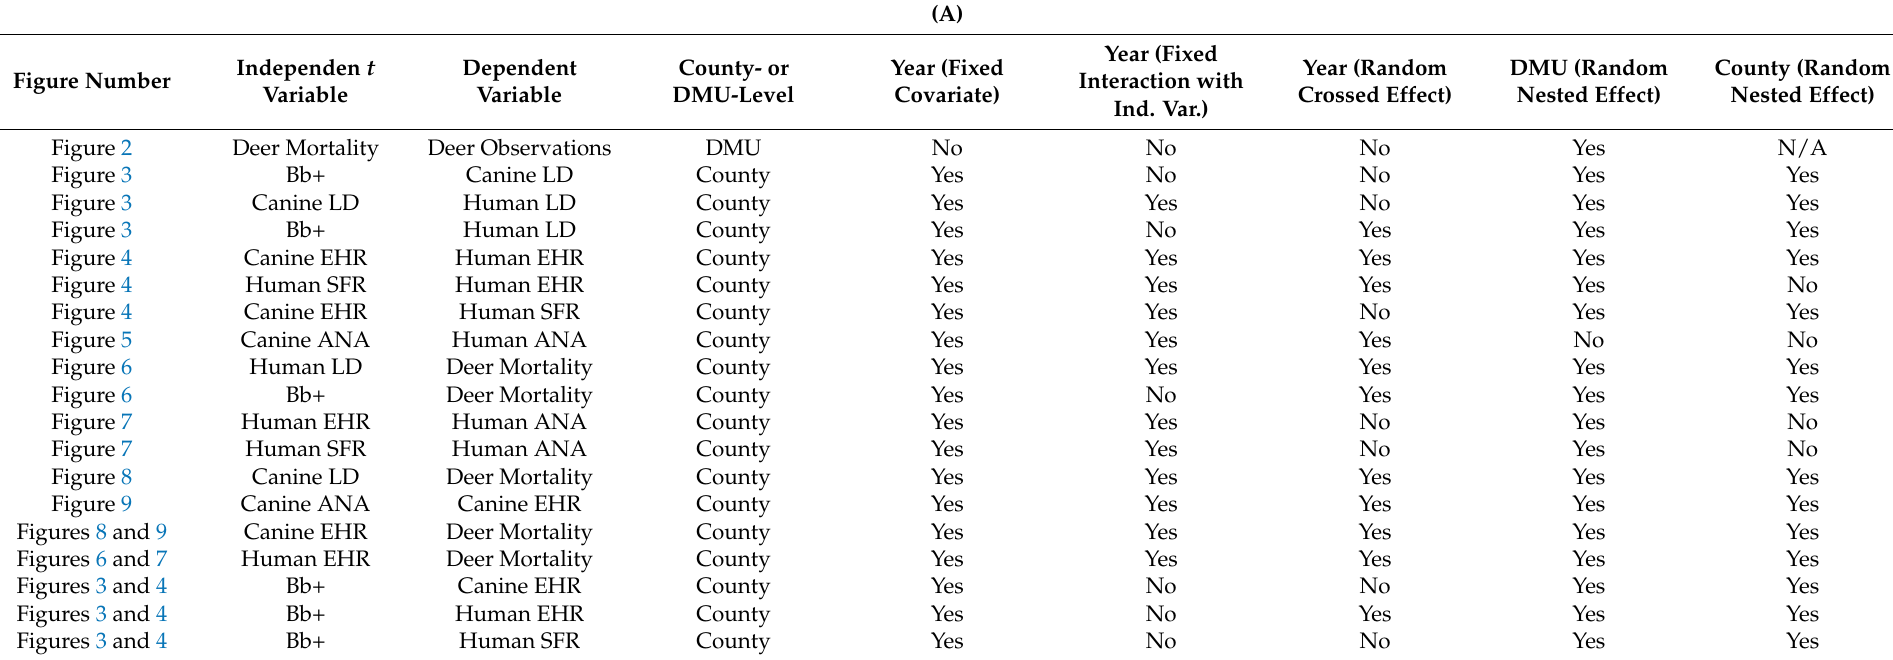
Table 6. ( A ) Summary of Mixed Effects Models (MEMs) conducted between variable pairs. Each pair lists the model components and parameters used in their final MEM: the level of analysis (DMU or County) and the inclusion of the fixed effect of Year (i.e., time), of the fixed effect of Year’s interaction with the Main Effect Each, the random nested effect of DMU, the random nested effect of County, and the random crossed-effect of Year across the nested DMU > County groups. Each pair includes Table 6 of its associated spatial comparison map, if applicable. DMU = Deer Management Unit; MEM = Mixed Effects Model; LD = Lyme Disease; Bb = Borrelia burgdorferi ; Bb+ = Percentage of ticks infected with Bb; EHR = Ehrlichiosis; SFR = Spotted Fever Rickettsiosis; ANA = Anaplasmosis. ( B ) Summary of the outcomes of the Mixed Effects Models (MEMs) conducted between variable pairs. Each pair lists the Main Effect (i.e., of the Independent Variable on the Dependent Variable), Time Effect (i.e., of Year on the Dependent Variable), and Interaction Effect (i.e., of Year on the Main Effect); all effects are listed in format Coefficient (Standard Error), with their associated significance indicated by ** ( p < 0.05), * ( p < 0.1), or no asterisk ( p ≥ 0.1). Effects that could not be estimated are indicated by a double dash (–). Each pair also lists its models’ number of observations (n), the total number of nested groups (k), and the outcome of a Likelihood-Ratio test conducted between the model and a simple linear regression. Each pair includes Table 6 of its associated spatial comparison map, if applicable. DMU = Deer Management Unit; MEM = Mixed Effects Model; LD = Lyme Disease; Bb = Borrelia burgdorferi ; Bb+ = Percentage of ticks infected with Bb; EHR = Ehrlichiosis; SFR = Spotted Fever Rickettsiosis; ANA = Anaplasmosis.